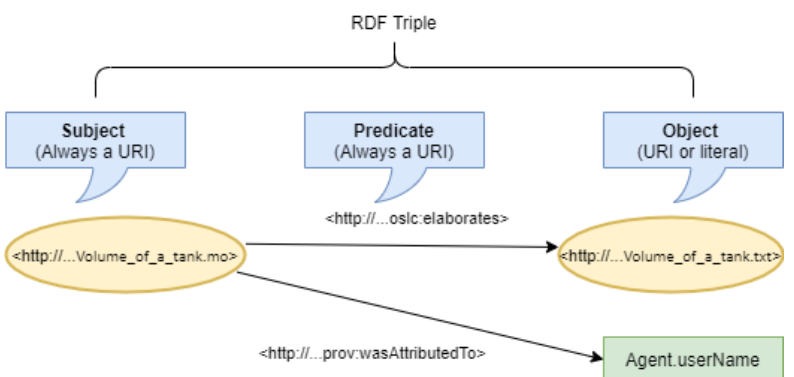
Figure 4. Trace link representation using an RDF triple